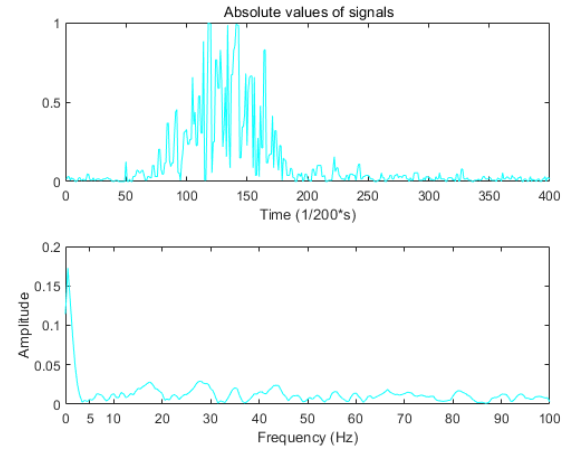
Figure 4. Fourier transform for the absolute values.